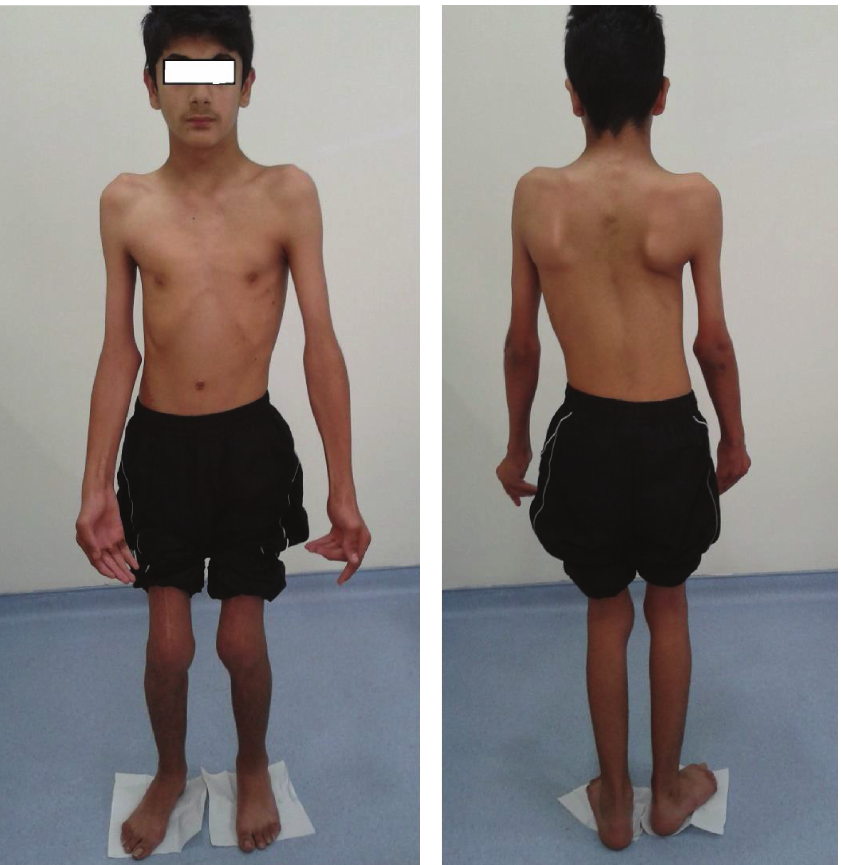
Figure 1: There were ptosis of the left eyelid, generalized muscle atrophy, weak body parts, webs/membranes (pterygium) of the neck, elbows, wrists, and fingers, semiflexed position in the elbows and knees, pes equinovalgus deformity of the right foot, flattening of the lumbar lordosis, C-type scoliosis with the thoracic curve to the right, and winged scapula.